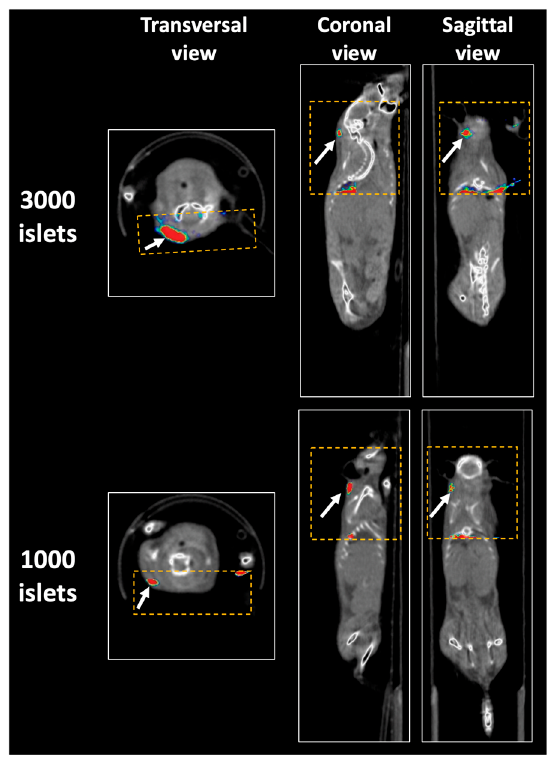
Figure 2. SPECT imaging of human islets grafted in immunodeficient mice using an anti-DPP6 nanobody. Female NOD-SCID mice were transplanted subcutaneously in the intrascapular area with different numbers of primary human islets (1000 or 3000 islet equivalent (IEQ)) as described [101]. After 4 weeks, the mice were imaged 60 min post-injection by full body CT followed by a focal single-photon emission computed tomography (SPECT) imaging scan using an 99m Tc-anti-DPP6 nanobody. The yellow square indicates the field-of-view of the SPECT camera. The white arrows indicate the graft localization. Full analyses and quantification of these pictures are described in [101].